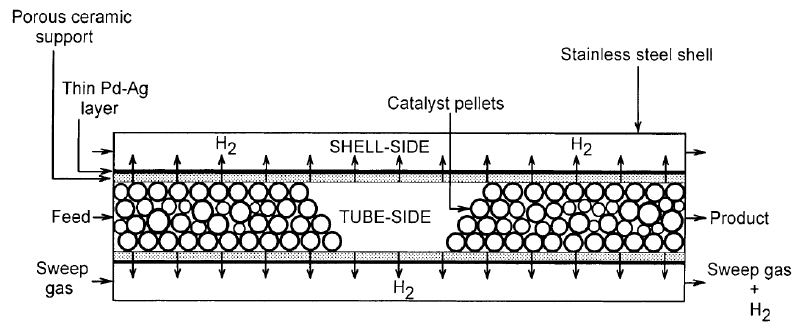
Figure 14. Schematic of the co-flow membrane reactor [53].